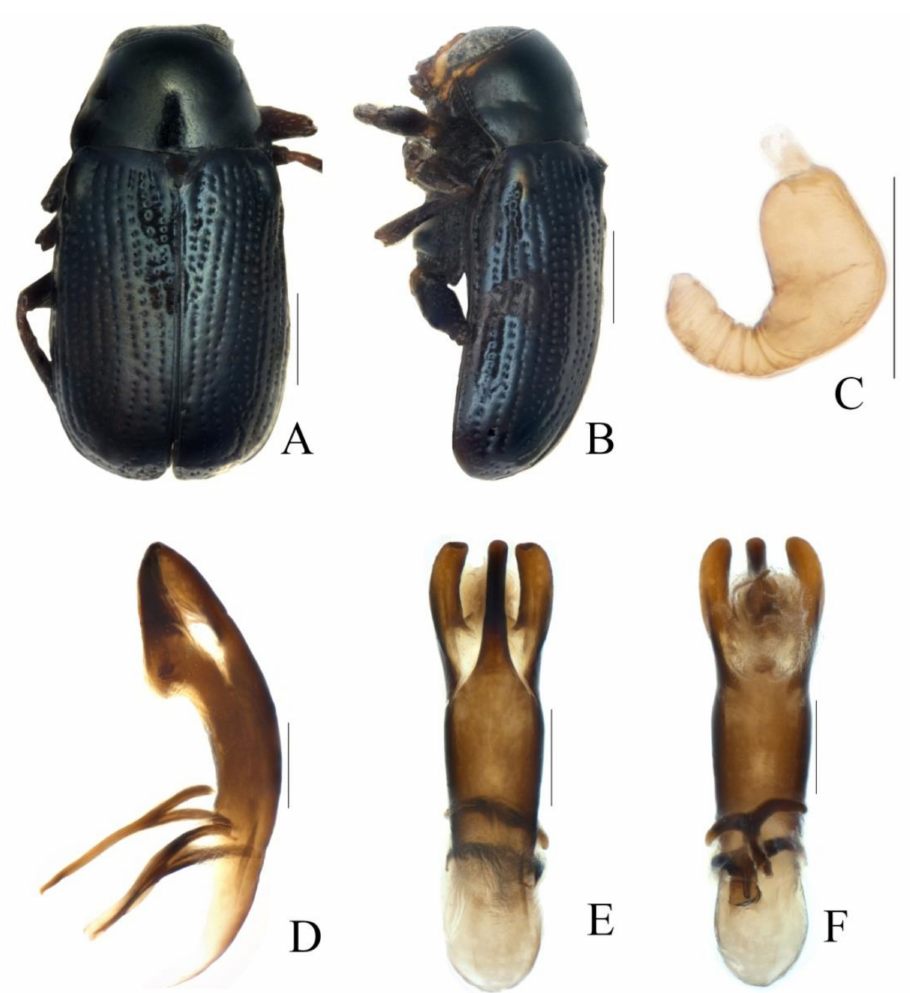
Figure 4. Cryptocephalus ( Burlinius ) baowenzhengi Duan & Zhou, sp. nov.: ( A ) habitus; ( B ) lateral view of habitus; ( C ) spermatheca; ( D ) lateral view of aedeagus; ( E ) dorsal view of aedeagus; ( F ) ven- tral view of aedeagus. (Scale bars: ( A , B ) = 0.5 mm, ( C – F ) = 0.2 mm) (( A , B , D – F ): holotype, male; ( C ): paratype,